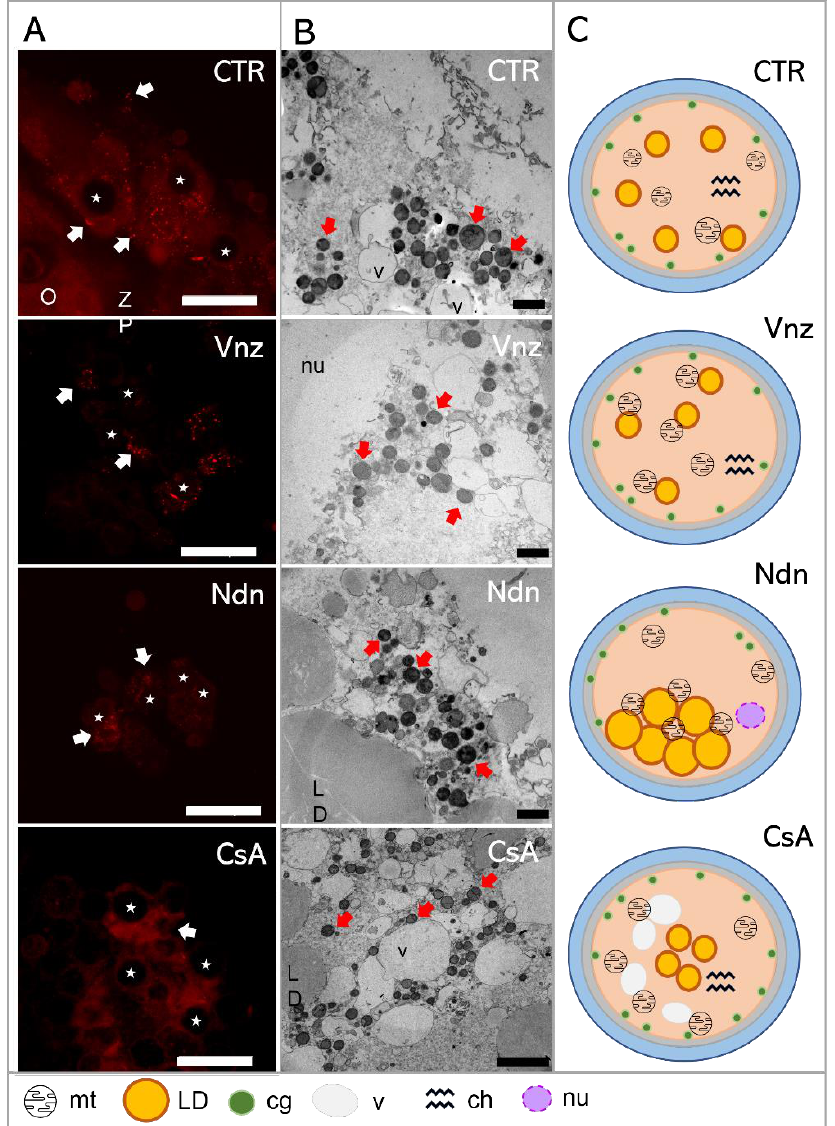
Figure 6. ( A ): Representative images of MitoTracker Orange CM-H2TMRos-positive mitochondrial distribution in porcine CCs subjected to the IVM procedure using a 3D culture model (alginate capsules) in control cultures (CTR) or in experimental cultures: in the presence of vinclozolin (Vnz), nandrolone (Ndn) or cyclosporin A (CsA). ( B ): Transmission electron micrographs of ultrastructure in porcine oocytes subjected to the IVM procedure using a 3D culture model in CTR or in the presence of Vnz, Ndn or CsA. ( C ): A diagram summarizing the results of the ultrastructure analysis of the oocyte and the distribution of organelles in their ooplasm after the completion of 3D-IVM in the presence of selected EACs. O—oocyte; ZP—zona pellucida; LD—lipid droplets; v—vacuole; cg—cortical granules; nu—nucleus; red arrows—mitochondria; stars—nuclei of CCs. Scale bars represent 1000 nm. MtOR magnification 60×.